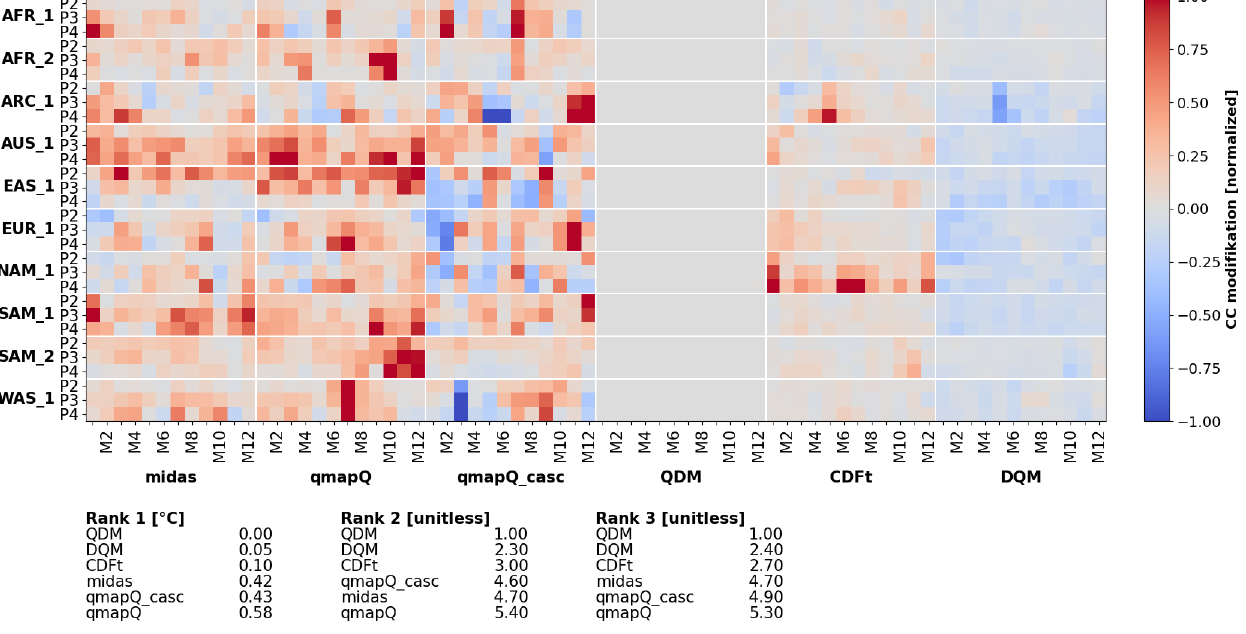
Figure 9. The same as Fig. 7 but for mean temperature.